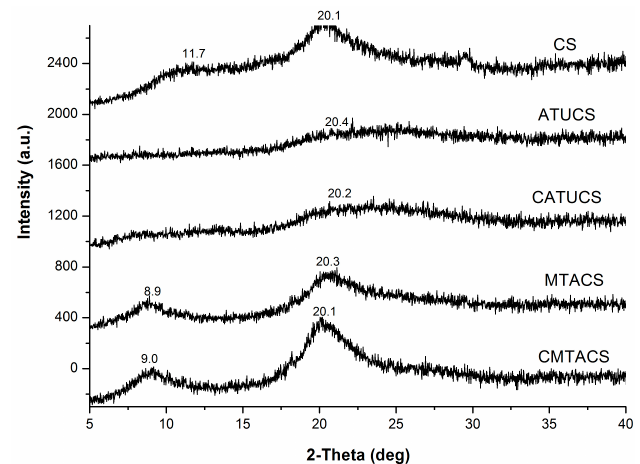
Figure 3. XRD patterns of chitosan (CS), acetyl thiourea chitosan (ATUCS), 3-methyl-1,2,4-triazolyl chitosan (MTACS), chloracetyl thiourea chitosan (CATUCS), and 3-chloromethyl-1,2,4-triazolyl chitosan (CMTACS) derivative.